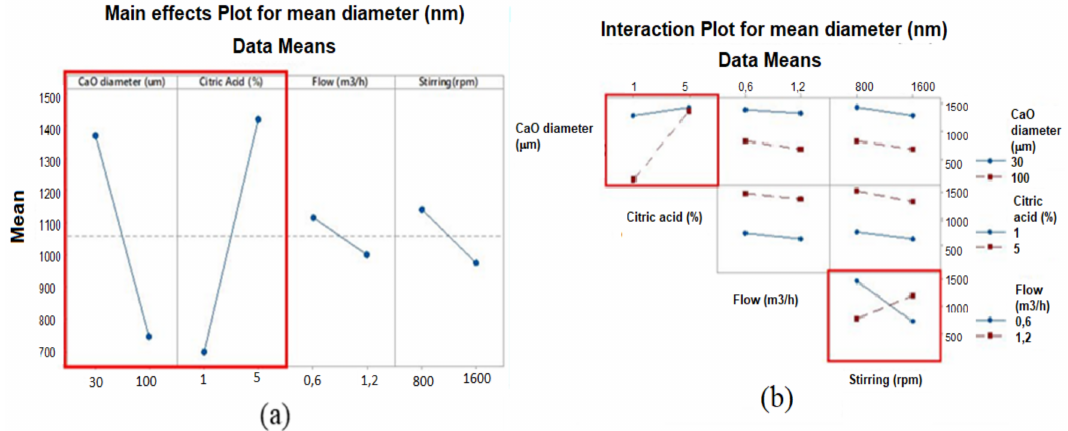
Figure 5. ANOVA graphs about effect of parameters: ( a ) main effect plot for mean diameter; ( b ) interaction